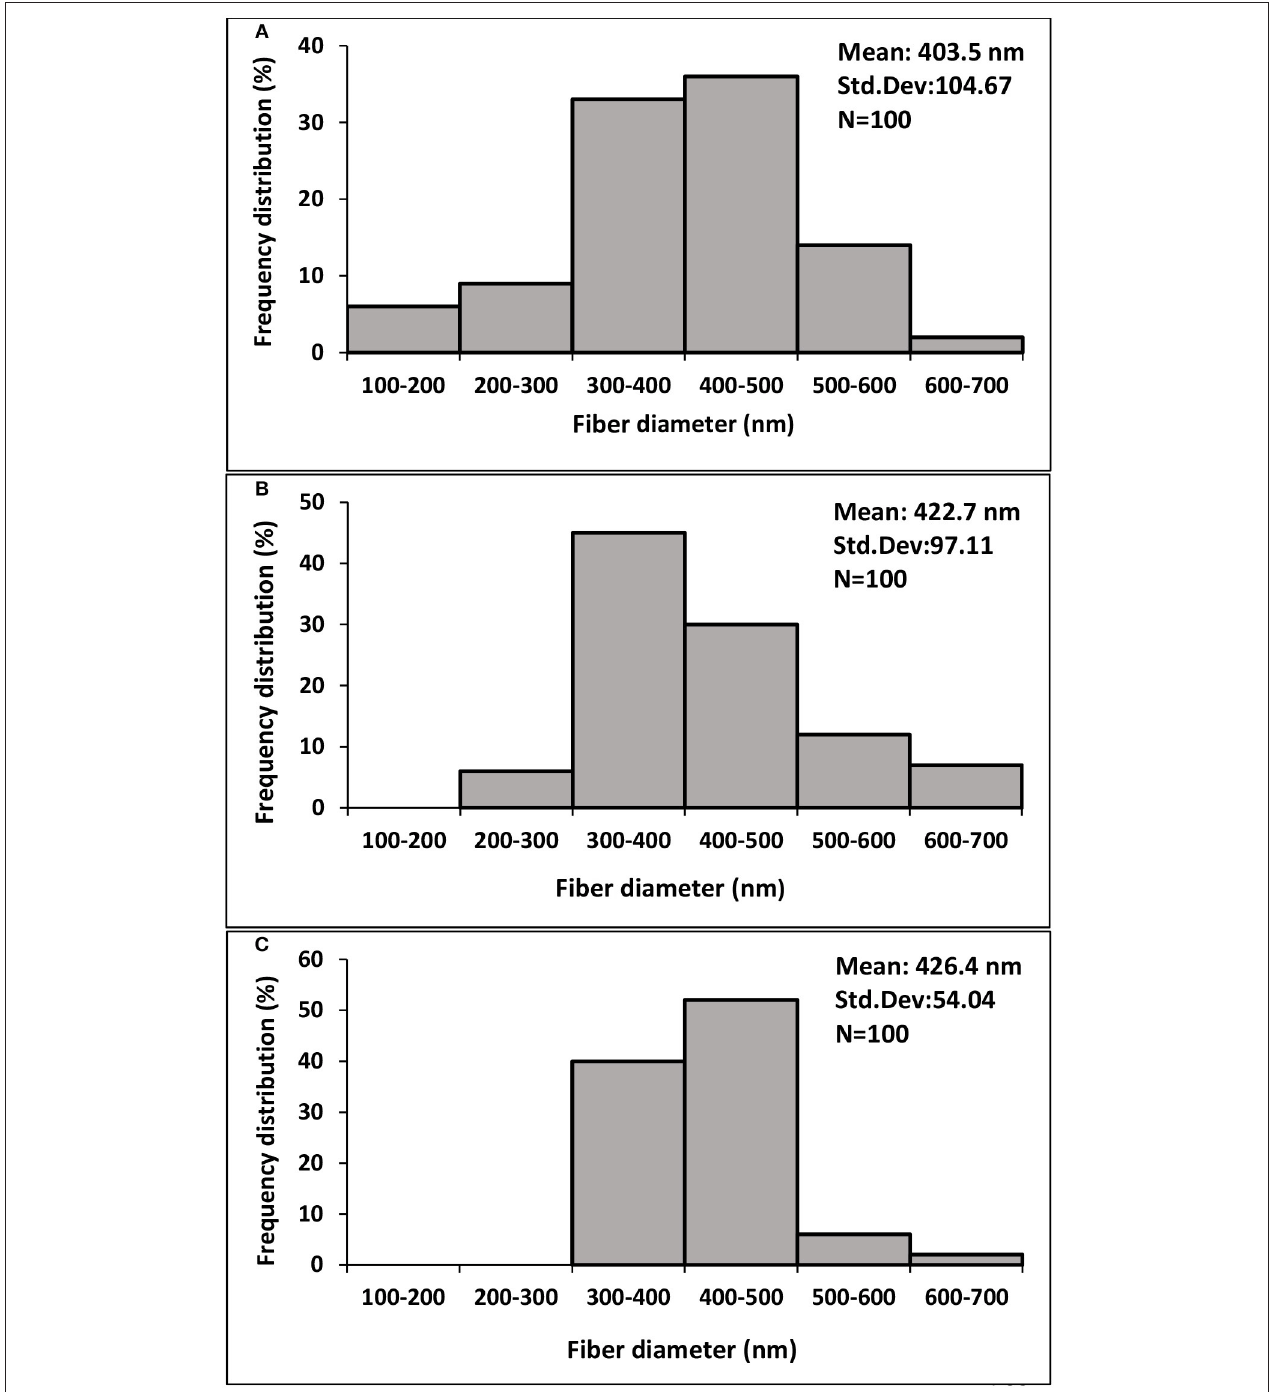
FIGURE 3 | Fiber diameter distribution diagrams of GTA crosslinked nanofiber mats based on (A) SF, (B) SF/gelatin 90/10, (C) SF/gelatin 70/30. “Std. Dev” represents the standard deviation of data.